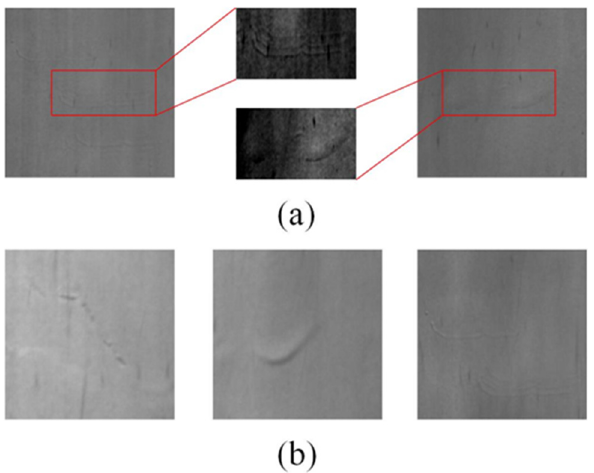
Figure 1. Characteristics of roll marks. ( a ) Two samples of roll marks, red rectangles mark the roll marks which has low contrast with the background and we make the roll marks explicit; and ( b ) three roll marks with completely distinct appearances.